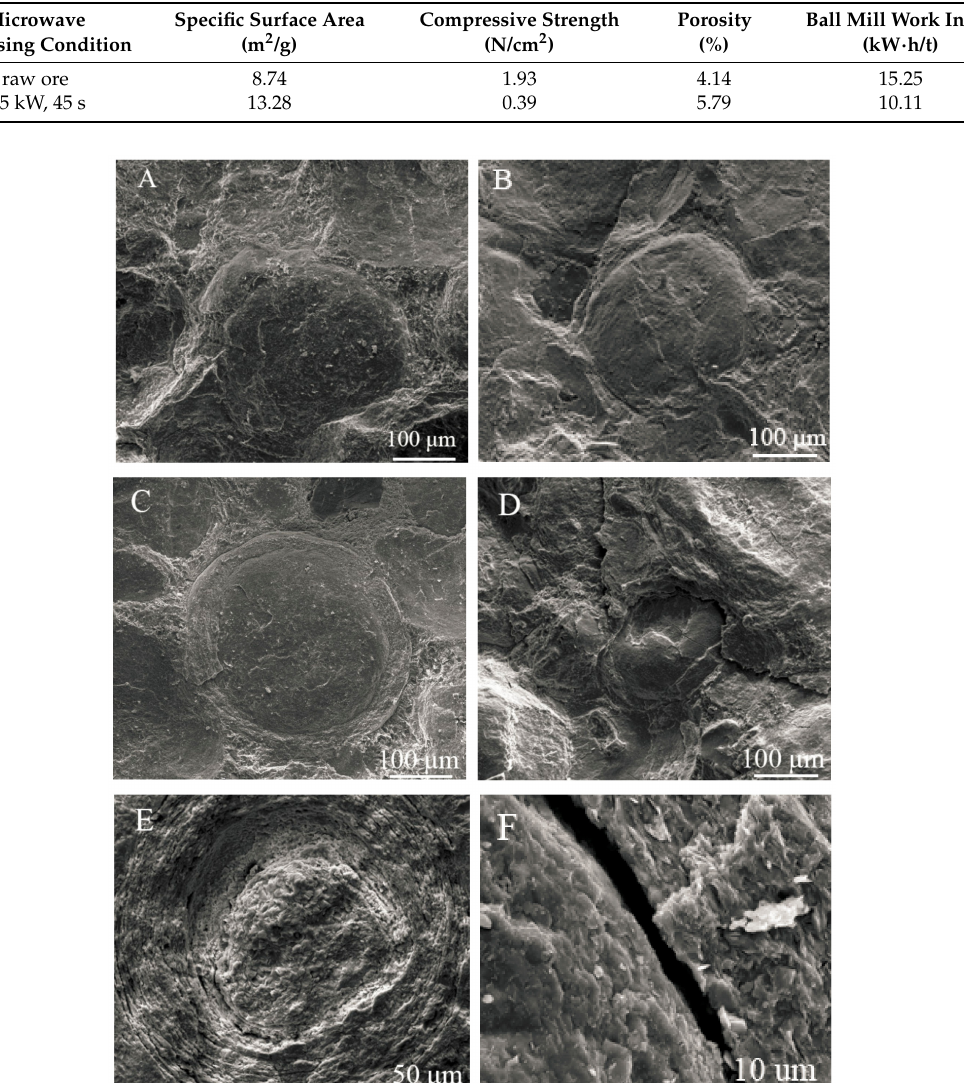
Figure 3. SEM images for different microwave processing conditions. ( A ) No treatment; ( B ) 1.5 kW, 45 s; ( C ) 2 kW, 45 s; ( D ) 2 kW, 60 s; ( E ) 2.5 kW, 45 s; ( F ) fraction enlargement of